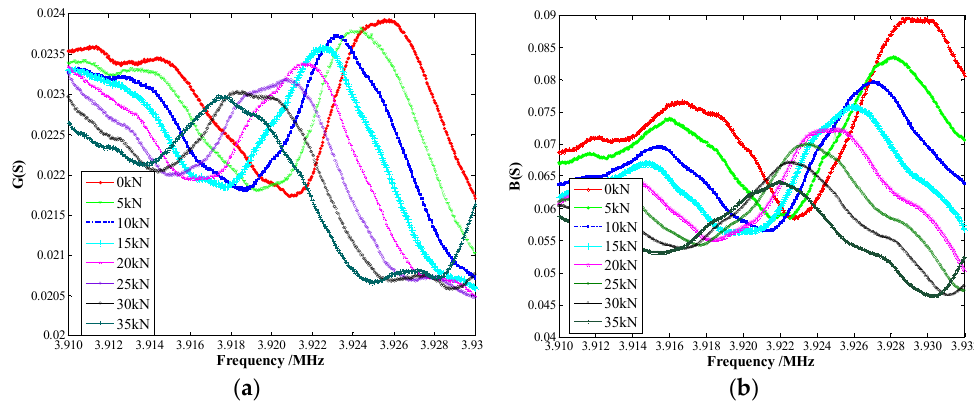
Figure 4. M16 bolt under different axial force: ( a ) Conductance; and ( b ) Susceptance.